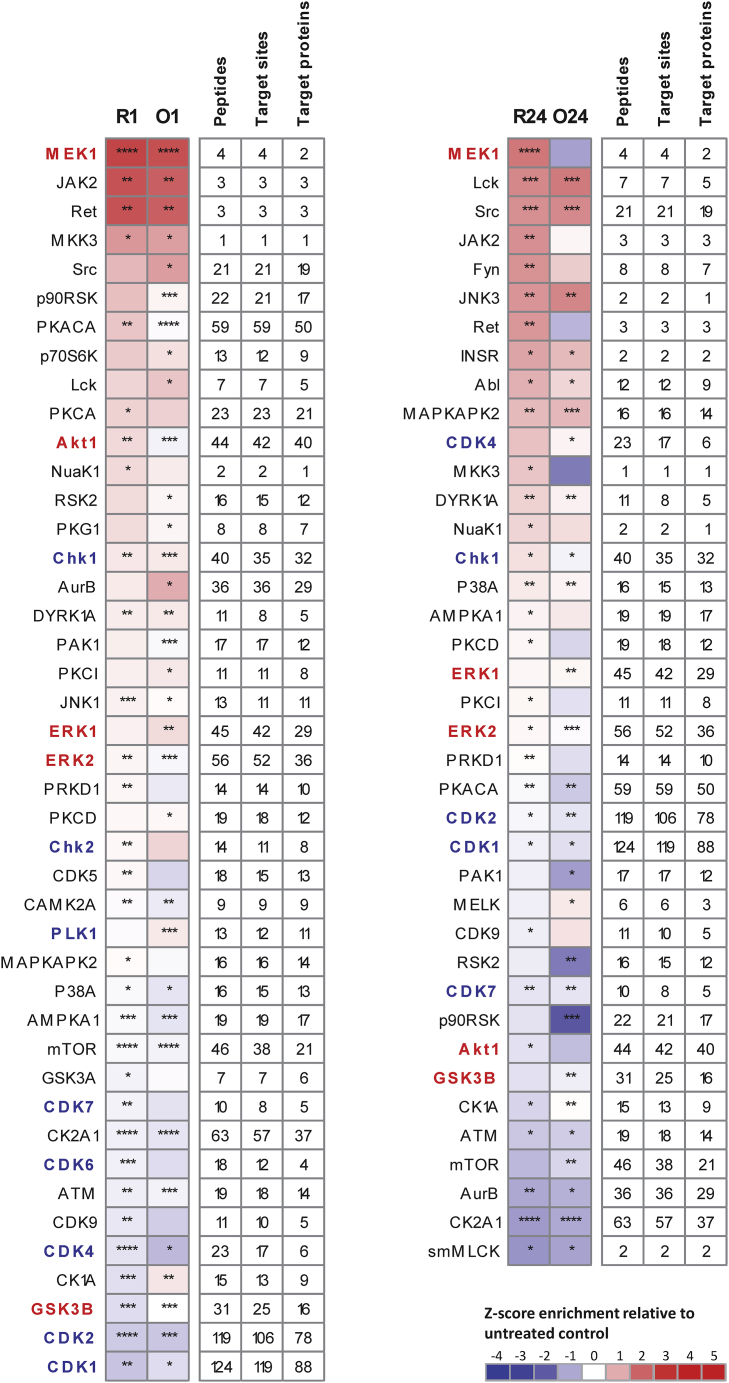
Kinase activity changes after rituximab or obinutuzumab treatmentSU-DHL4 cells were treated with 5 μg/mL rituximab (R) or obinutuzumab (O) for 1 h (R1 and O1; left) or 24 h (R24 and O24; right), and changes in kinase activities were inferred relative to untreated controls. The heatmaps show the Z score enrichment of substrate groups for the different kinases calculated by the KSEA algorithm. Kinases belonging to the KEGG pathway “B-cell receptor signaling” are indicated in red, and those belonging to the KEGG pathway “cell cycle” are indicated in blue. Peptides: number of peptides containing a phosphorylation site regulated by respective kinase; Target sites: number of phosphorylation sites measured for respective kinase; Target proteins: number of proteins that the phosphorylation sites regulated by the respective kinase map to. ∗p<0.05, ∗∗p<0.01, ∗∗∗p<0.001, ∗∗∗∗p<0.0001 as inferred by the hypergeometric test followed by Benjamini-Hochberg multiple testing correction.